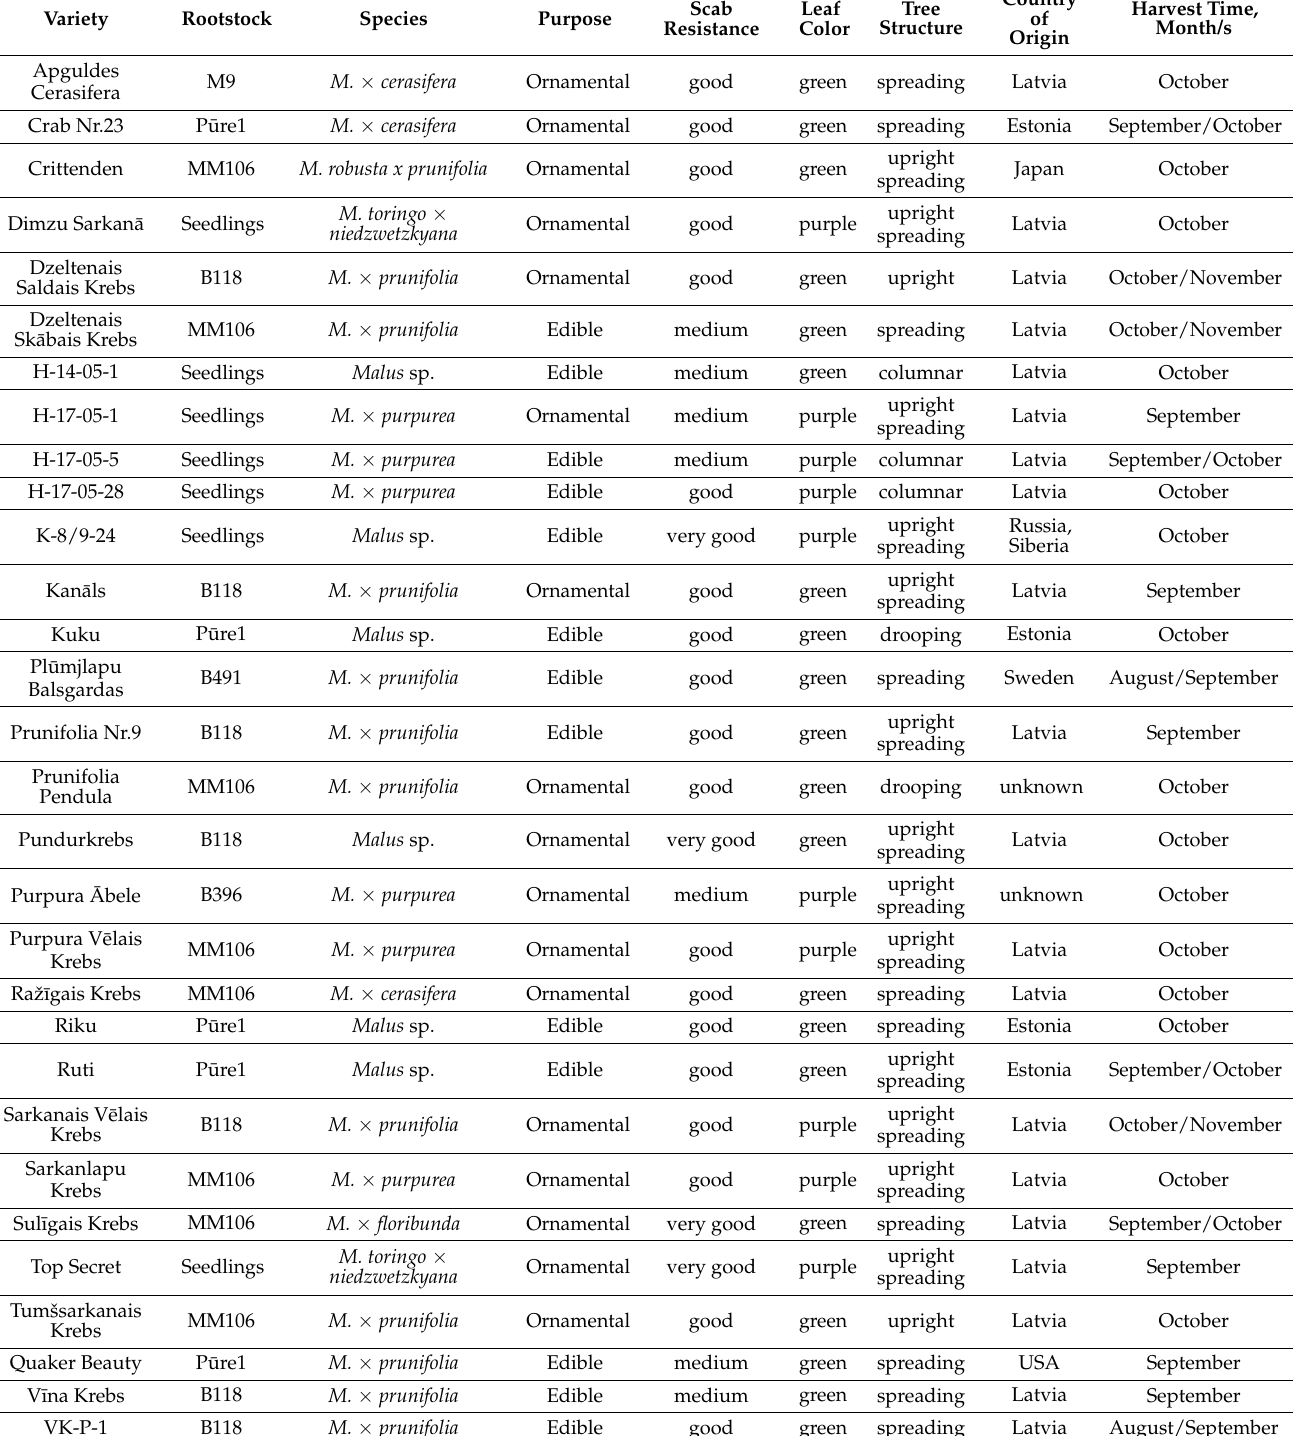
Table 1. Detailed information about studied crab apples ( Malus